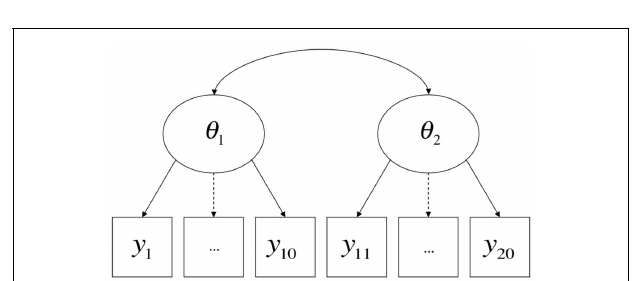
FIGURE 4 | Item types as primary